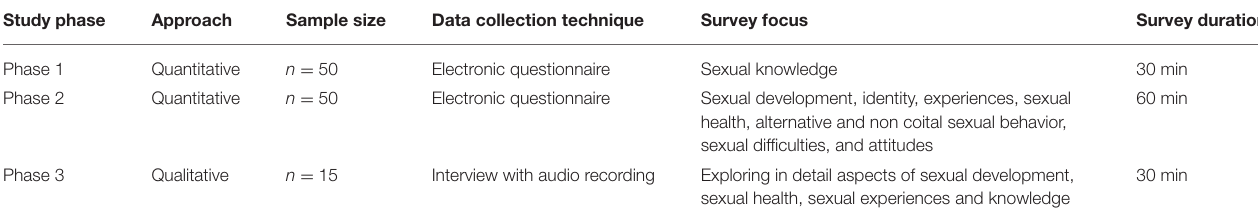
TABLE 3 | Study phases and data